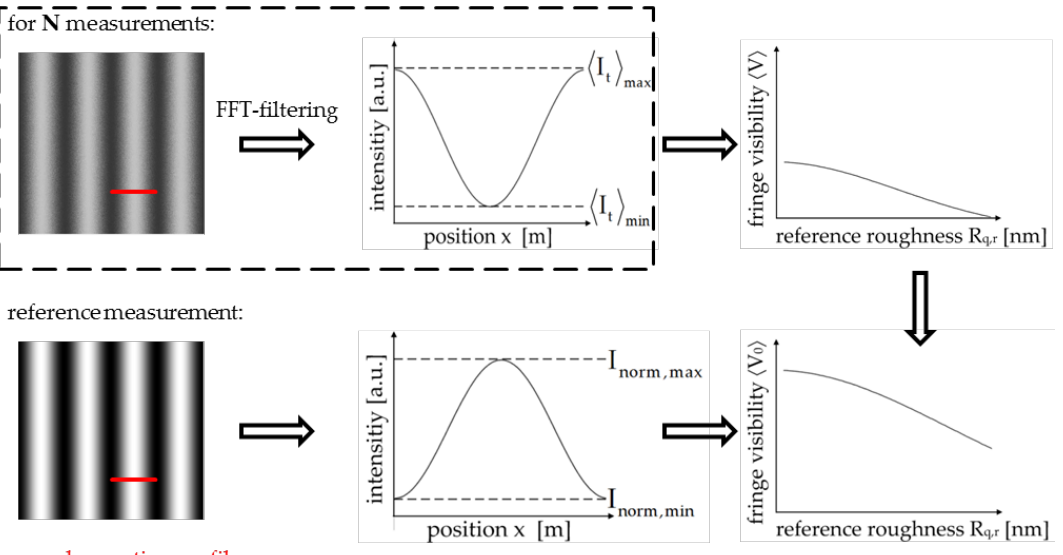
Figure 7. Flow chart for the measurement procedure and data acquisition. N: number of measurements